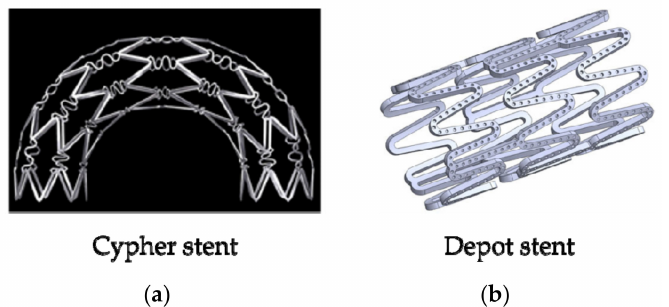
Figure 4. Two structures of DESs: ( a ) Cypher stent [40,41]; ( b ) Depot stent